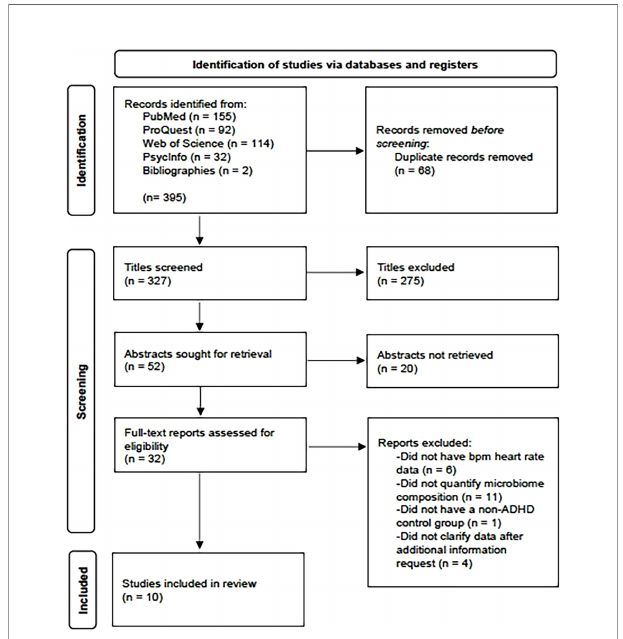
FIGURE 2 | PRISMA fl owchart for the number of studies identi fi ed, screened, and included in the meta-analysis process. PRISMA, Preferred Reporting Items for Systematic Reviews and